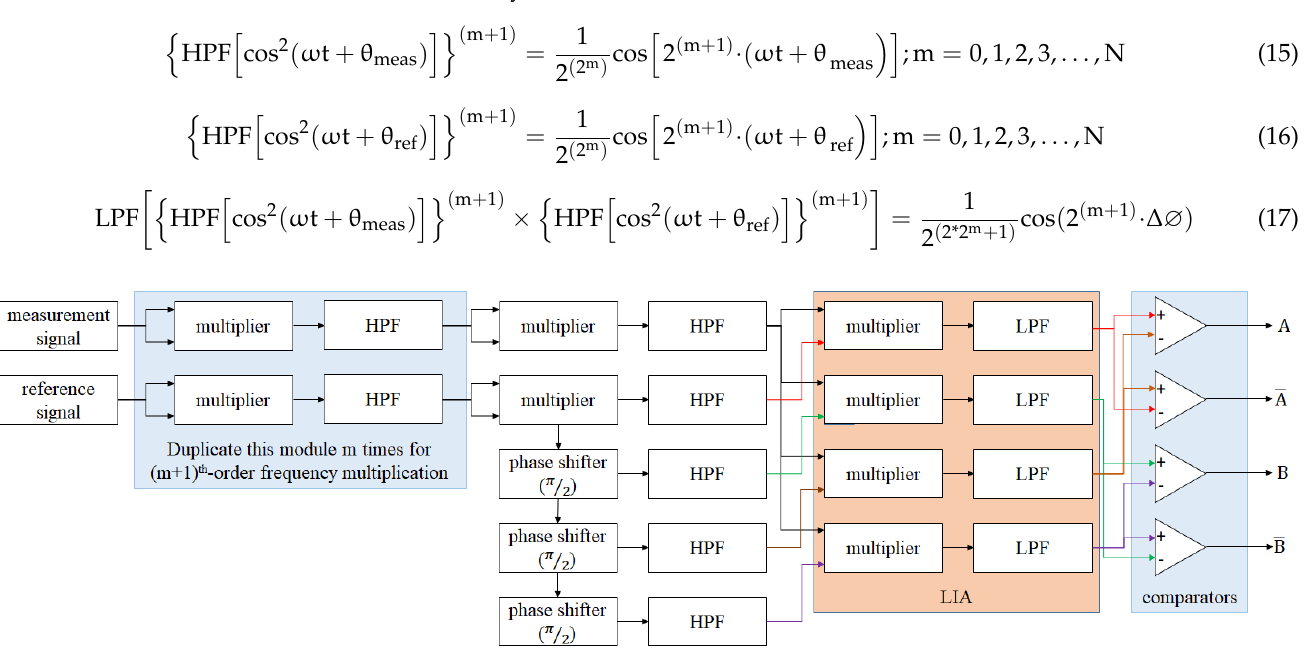
Figure 6. Block diagram of the multi − order analog interpolator.